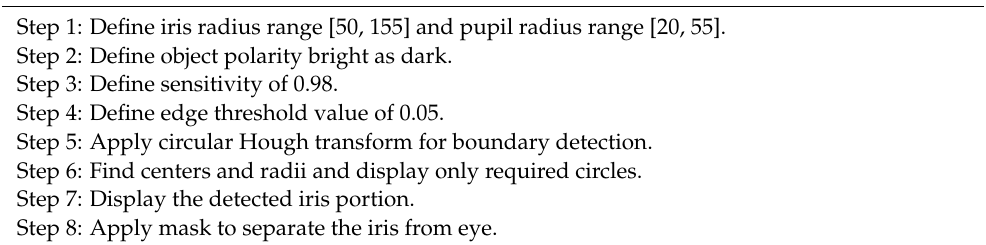
Algorithm 2: Circle Detection Using Circular Hough Transform